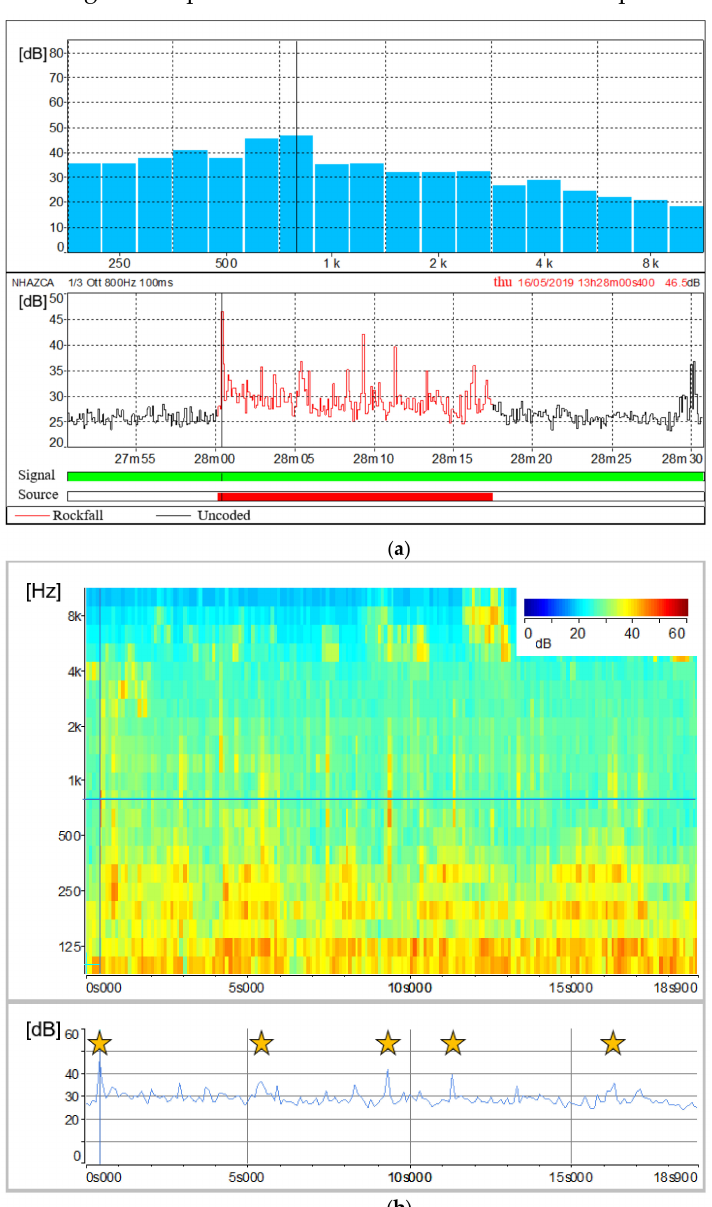
Figure 13. Overall representation of the acoustic signal emitted by the rockfall event on 16 May 2019 at 13:28 (UTC + 01:00): ( a ) Spectral time history of the rockfall event with the classified audio track (lower plot) and frequencies histogram (upper plot); ( b ) Focus on the audio track classified as rockfall by means of the sonogram showing the amount of sound pressure levels expressed in dB as a function of time and signal frequency. The plot at the bottom shows the amount of sound pressure levels over time at the frequency of 800 Hz. Yellow stars refer to different impacts recorded during the collapse. Temporal resolution is 0.1